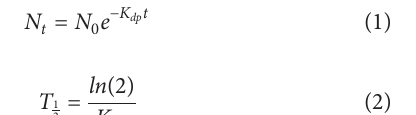
Supplementary Figure S2 . The mass spectrometry data pertaining to this experiment, which was used to generate these fi gures are available in Data Sheet 1 and Table S2